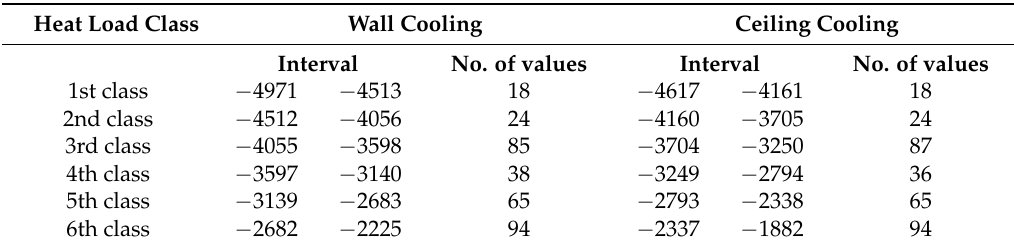
Table 2. Heat load classes.